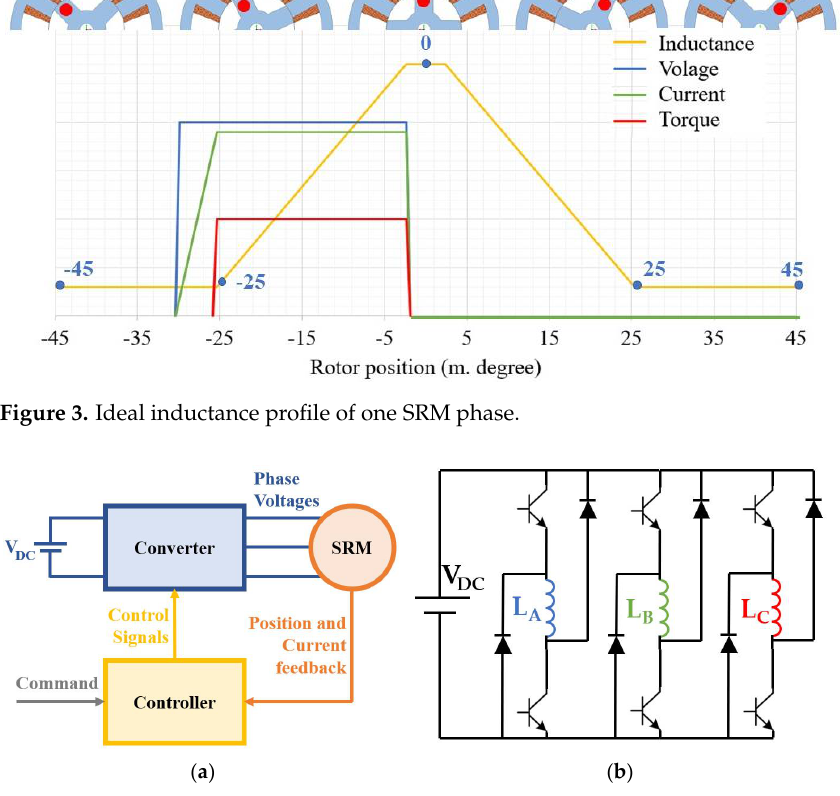
Figure 3. Ideal inductance profile of one SRM phase.